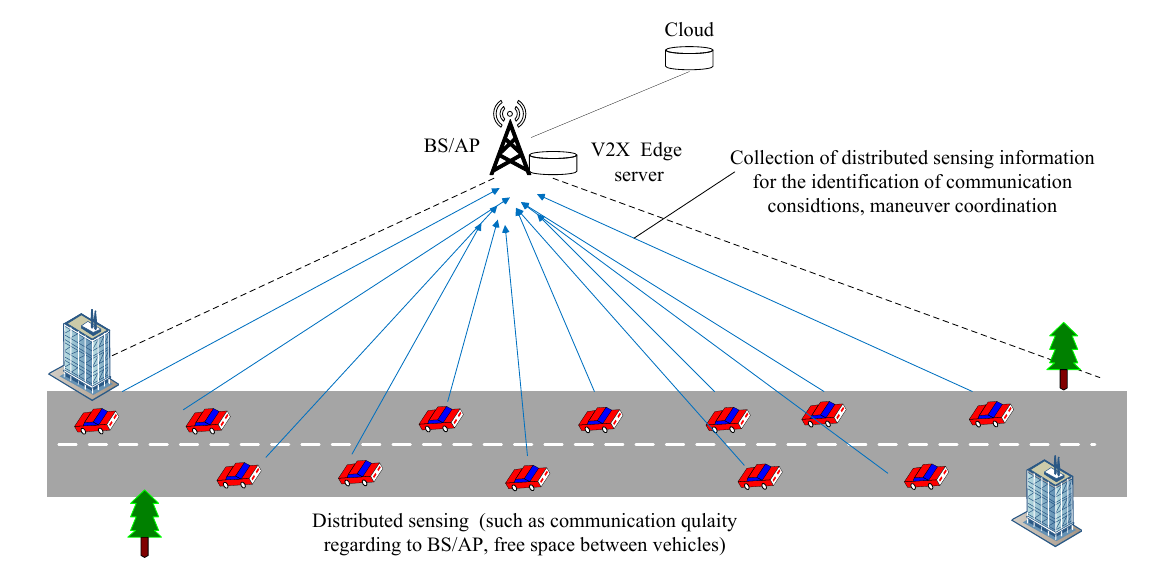
Figure 1. The extraction of sensing information from